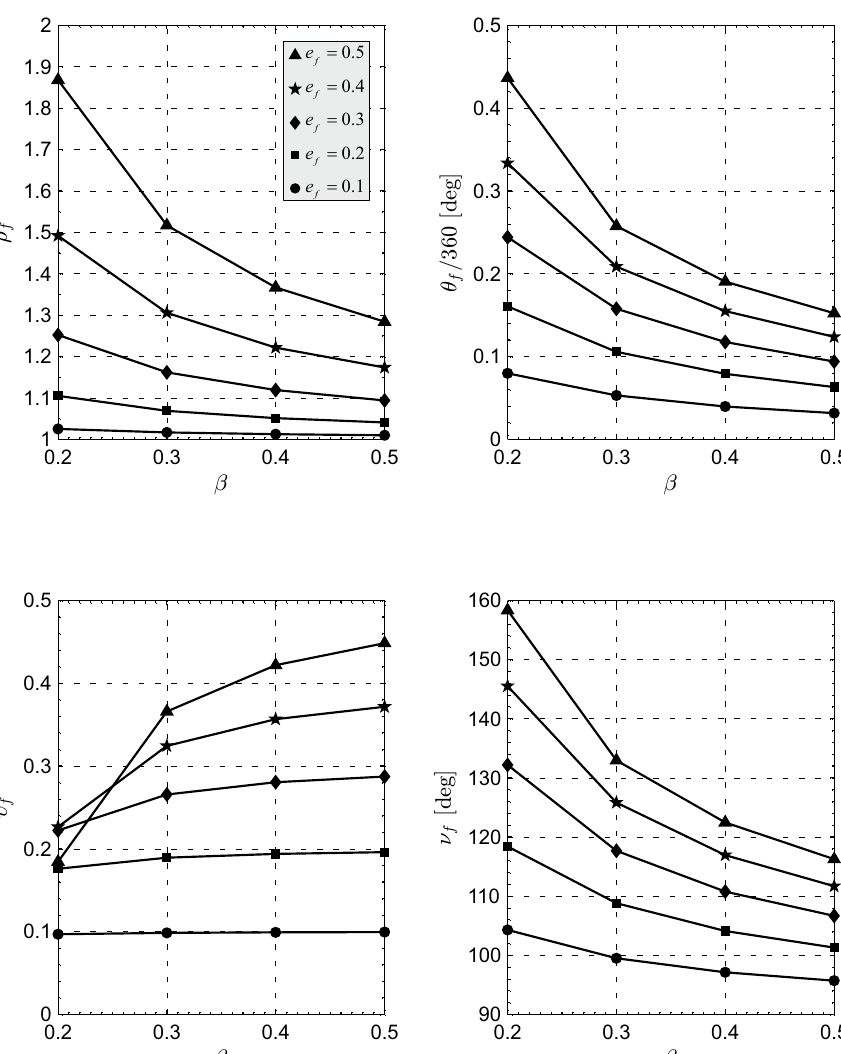
Figure 3. Characteristics of the rendez-vous point as a function of e f and β